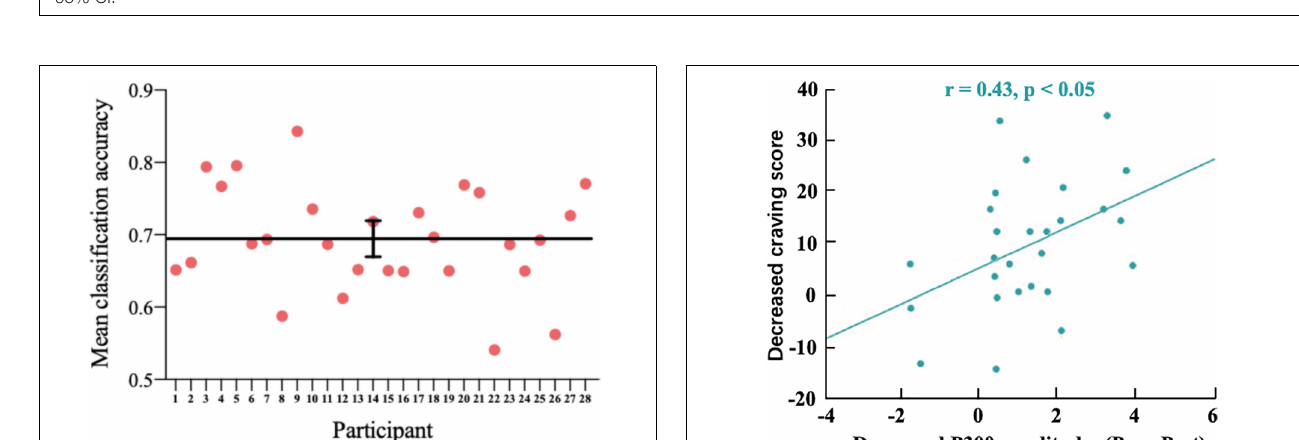
FIGURE 8 | Within two visit of neurofeedback learning, participants tried to reduce the probabilistic score ( r = − 0.1545, p = 0.0010). Error bar: SD; shaded area: 95% CI.